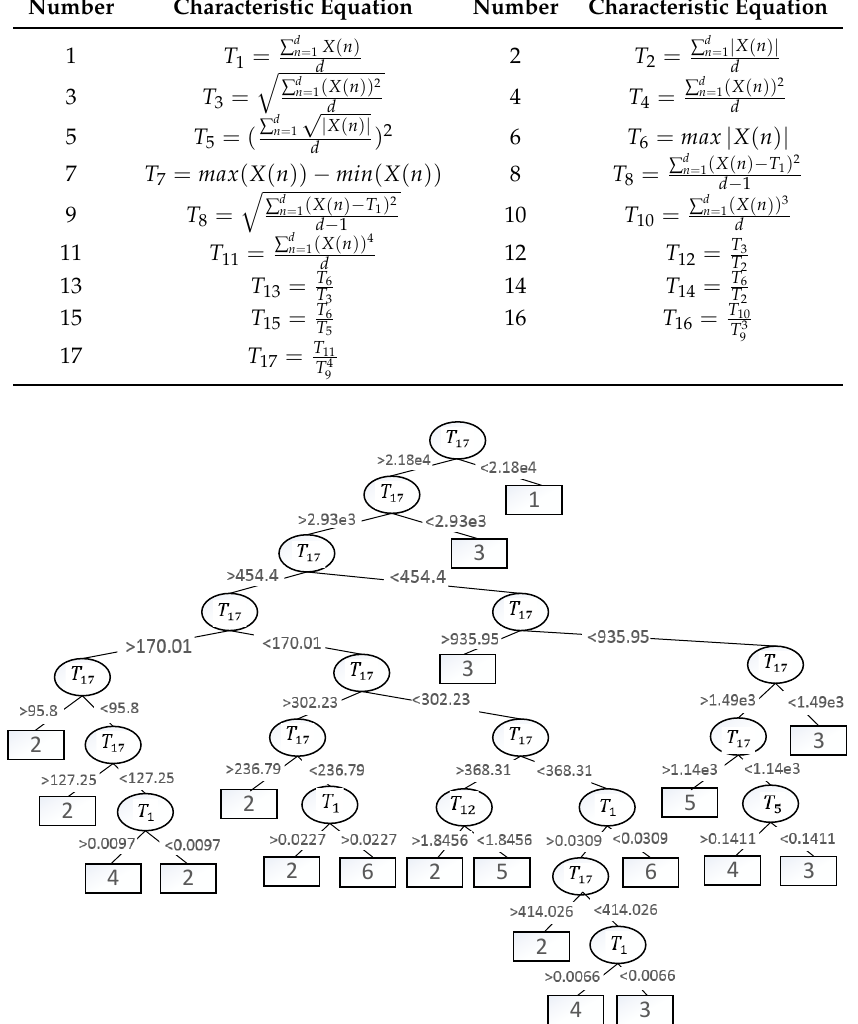
Figure 7. A part of the Decision